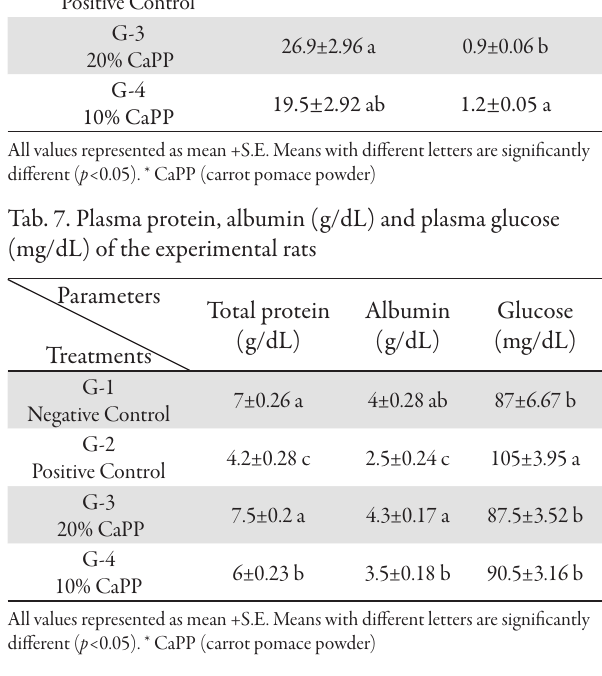
Tab. 8. Relative organs weight (g) of the experimental